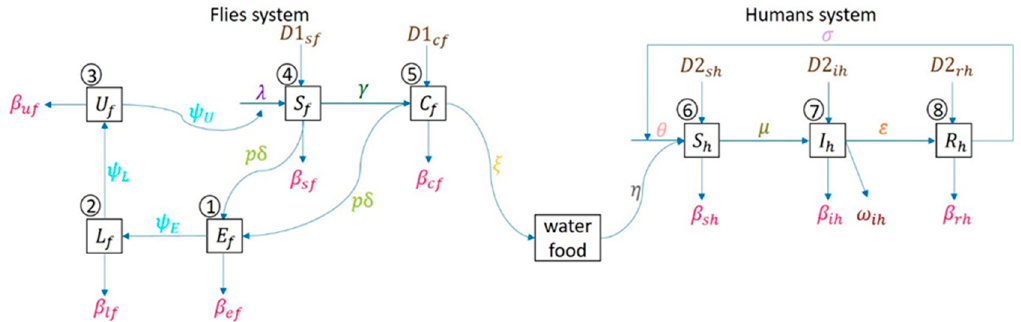
Figure 2. Network model of flies’ life cycle (egg-larva-pupa-adult) and human as susceptible-infected-recovered in compartmental model.